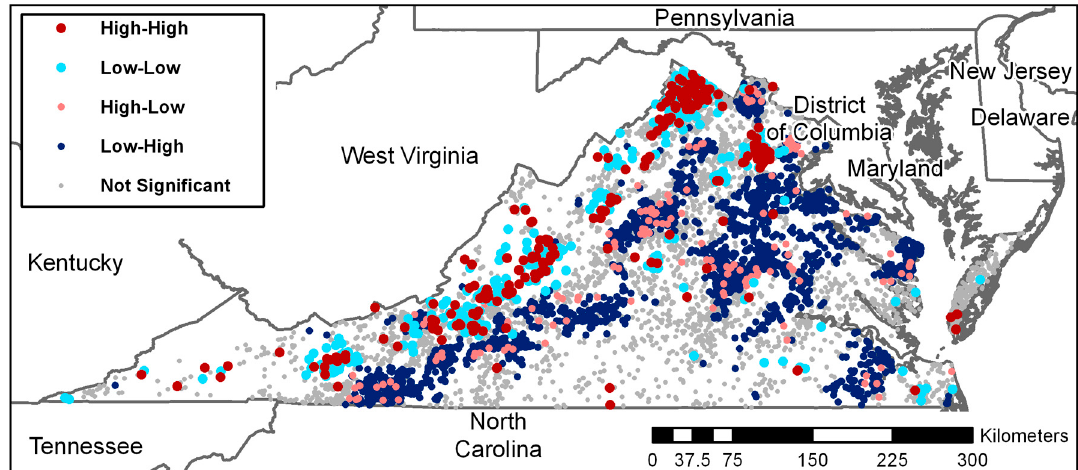
(PDW) samples collected 2014–2018.